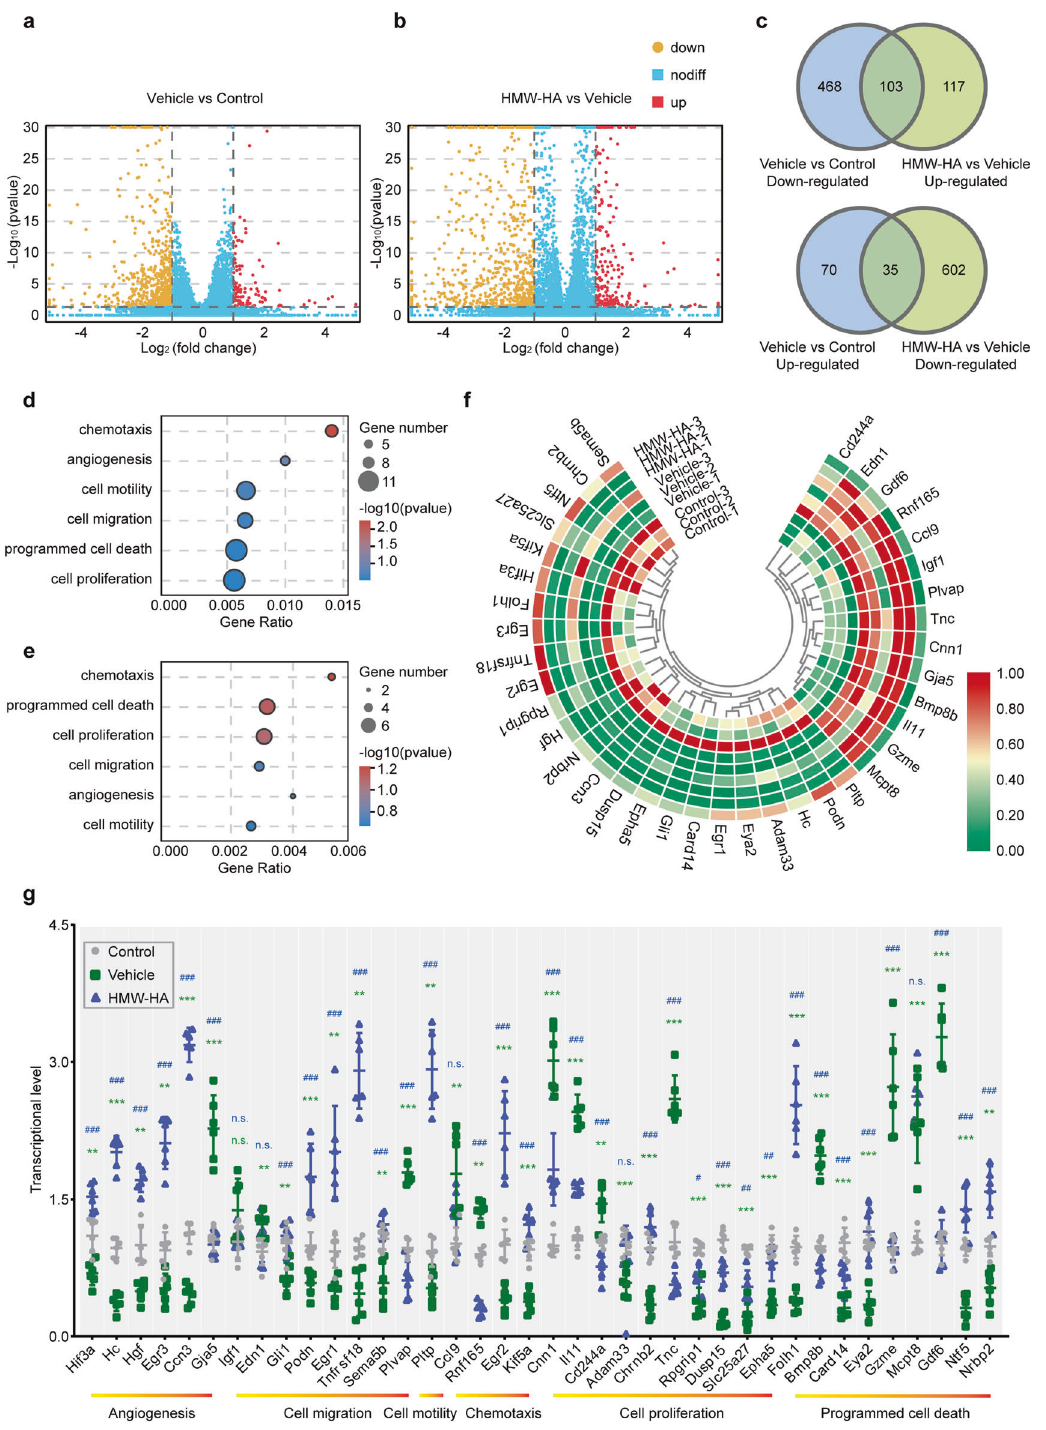
Fig. 6 Endothelial transcriptional changes following OGD and HMW-HA treatment. a , b The volcano plot for differentially genes (DEGs) expression. The x -axis represents the log2 (fold change), the y -axis represents the log10 ( p value) of the repeated test results. The red region contains the upregulated genes, and the green region contains the downregulated ones. Three biological replicates were used for RNA sequencing analysis. c Venn diagrams of the numbers of upregulated and downregulated gene changes in the endothelial cells observed following OGD with or without HMW-HA treatment, depicting the overlap of changes found in different groups. d , e GO term enrichment analysis of DEGs between d control and vehicle group and between e vehicle and HWA-HA group. The six biological process GO terms related to angiogenesis process was shown. The y -axis represents GO biological terms. The X -axis represents Gene ratio. The size of the dot represents the number of genes under a speci fi c term. The color of the dots represents the adjusted p -value. f The Heatmap image depicting transcriptional changes of the 38 selected genes in different groups. g Validation of transcriptional changes of the selected 38 genes using RT- qPCR analysis. Data is expressed as mean ± SD; n = 6 group; n.s. not signi fi cant, ** p < 0.01, *** p < 0.001 versus control group, n.s. not signi fi cant, # p < 0.05, ## p < 0.01, ### p < 0.001 versus vehicle group by one-way ANOVA followed by Tukey ’ s multiple comparison